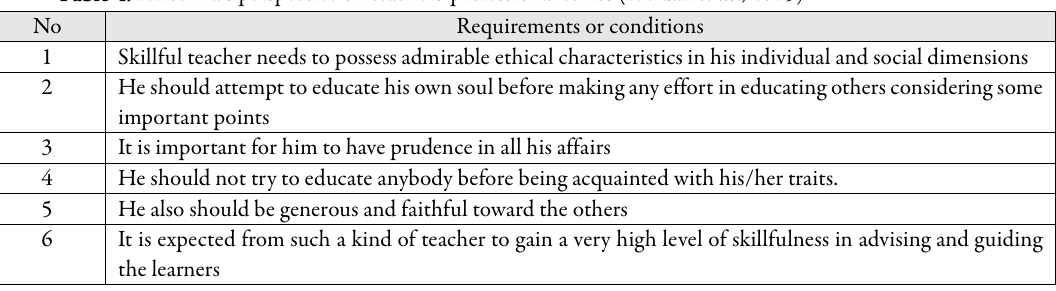
Table 4. Avicenna’s perspective on teachers , professional ethics (Heidari et al ., 2015)